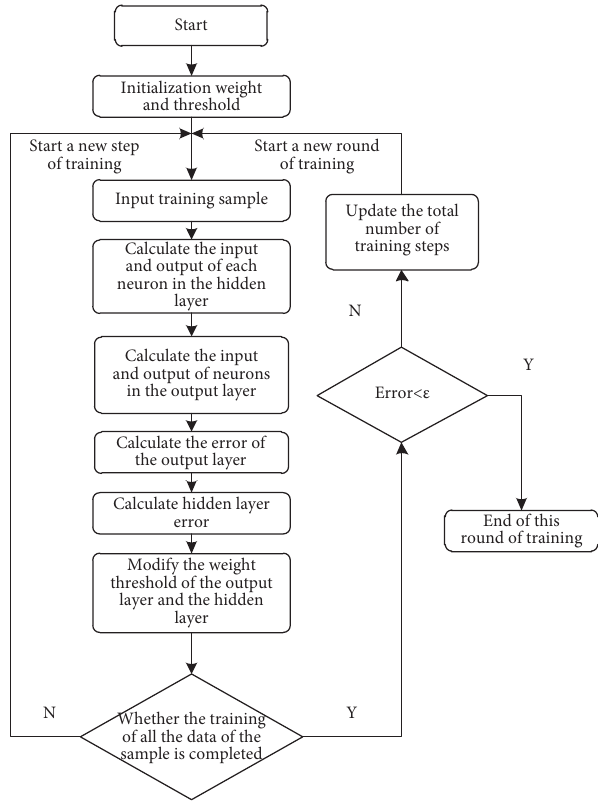
Figure 2: Calculation flowchart of BP neural